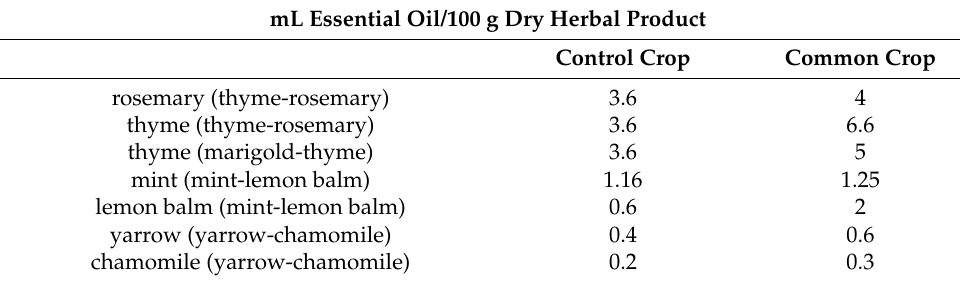
Table 5. Determining the amount of essential oil in certain vegetable products.